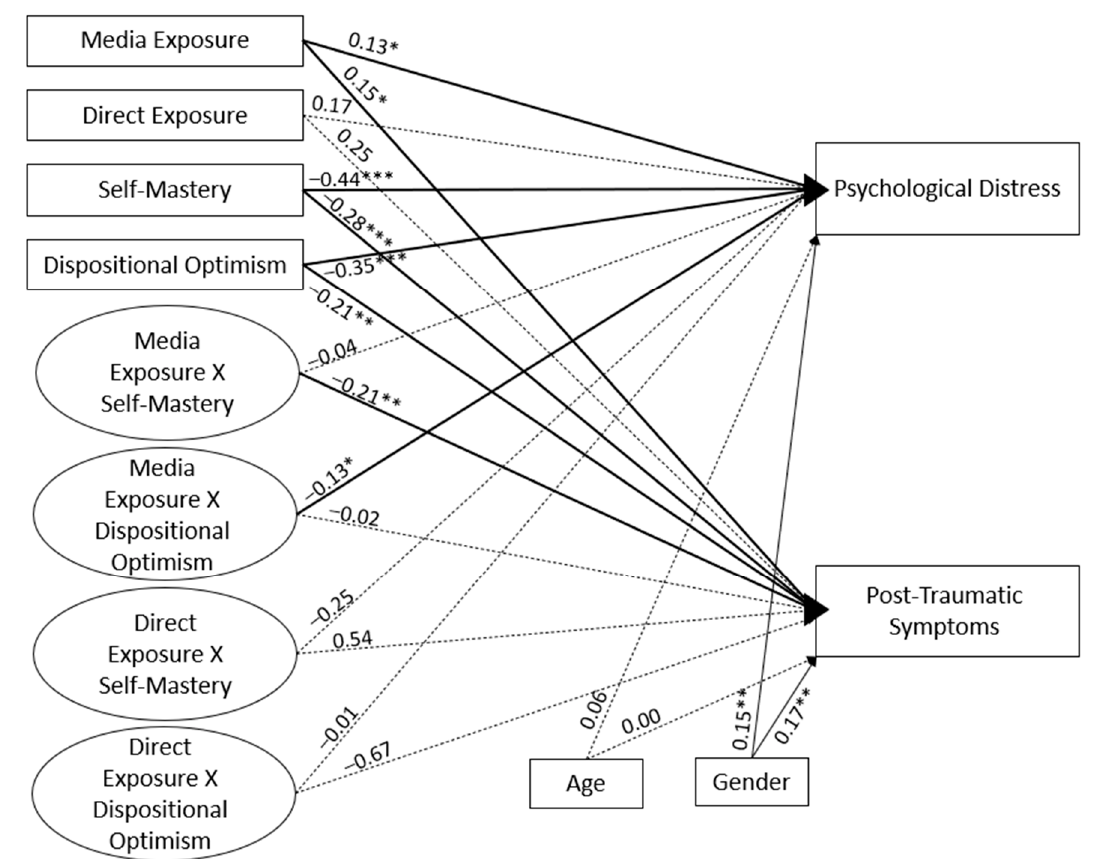
Figure 1. The structural equation model to explain the variance in general distress and post-traumatic symptoms by media exposure, previous direct exposure, self-mastery, and dispositional optimism. * p < 0.05; ** p < 0.01; *** p < 0.001. Coefficients are standardized.